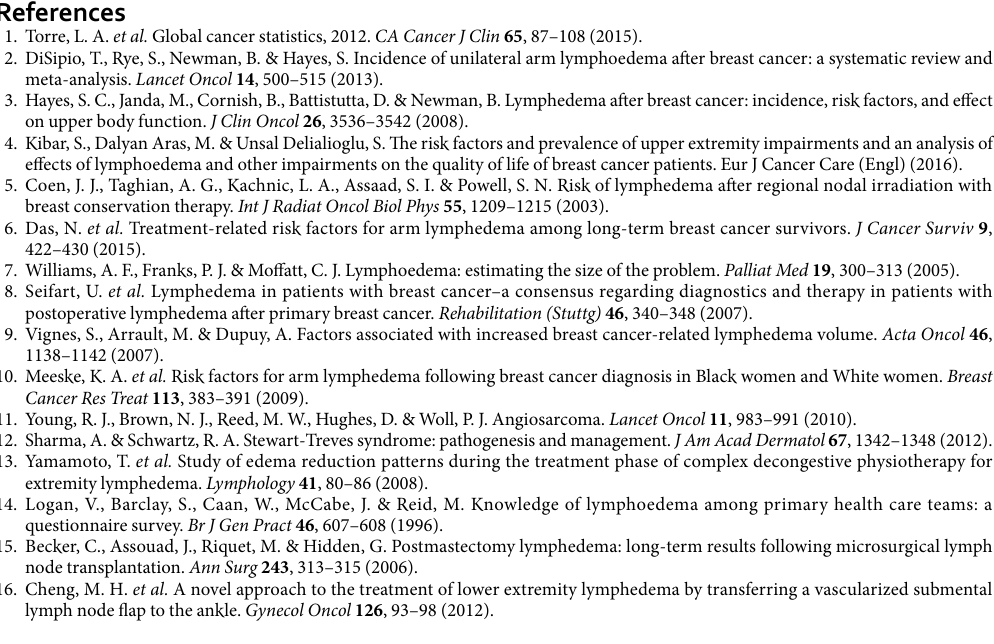
Postoperative treatment and follow-up strategy. For the surgery group, patients were placed in knee and hip flexion for 2 weeks to minimise tension at the abdominal site. The flap was monitored every 2 hours by nursing or surgical staff for the first 3 days. Decongestive bandage compression, avoiding the area with transplanted axillary lymph nodes and anastomosed vessels, was used continuously for the first year. In the physiotherapy group, in addition to the decongestive bandage compression, which was used as described for the surgery group, pneumatic compression was used for 20 min twice a day for the first 6 months and for 20 min every 2 days for the second 6 months. During the follow-up period, the upper limbs were measured at 6 points circumferences of the affected limb and patient responses to a questionnaire were used to evaluate improvement in lymphoedema at 7 days, 1 month, 3 months, 6 months, and 1 year following surgery. The questionnaire was patients’ subjective assessment about the affected limb, including swelling feeling, pain and numbness, and motion range. The criteria for evalu- ating treatment efficacy levels were as follows: significant efficacy: the circumference of the affected limb overall had totally recovered to that of the contralateral limb; moderate efficacy: more than or equal to 4 points of the whole affected limb circumference improved by one level; slight efficacy: the circumference of the affected limb in its entirety decreased but not by an entire level or no more than 4 points improved by one level; and no efficacy: the circumference of the affected limb did not change or it worsened. The measures of limb circumference and range of motion were carried out once by the same physiotherapist. Statistics. Propensity score matching was used to match patients between groups to balance their baseline data. Data were analysed by SPSS 21. Student’s t-test was used for measurement data, and Fisher’s exact test and logistic regression analyses were used for count data. At this manuscript, the follow up time was end by August 2016. The 12 patients enrolled during November 2012 to November 2013 had complete second year follow up data but not third year follow up data. And the 8 patients enrolled during December 2013 to October 2014 did not have complete second year follow up data. So, in this manuscript, only the first year follow up data was analyzed by statistic method. The second and the third year data were just described briefly.